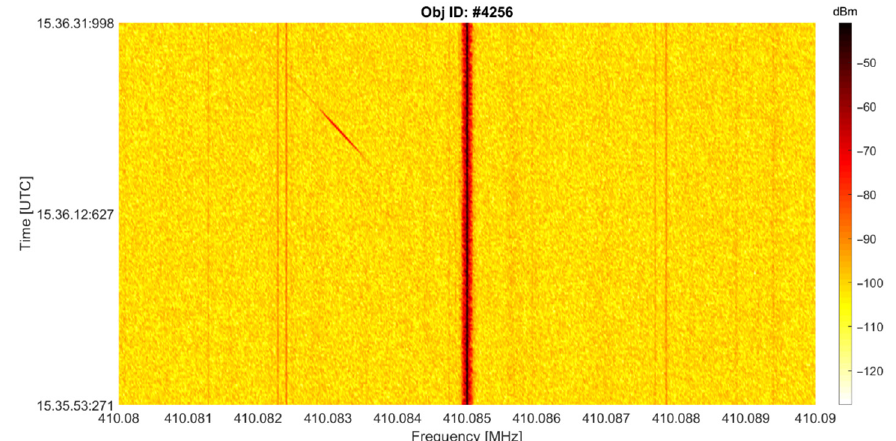
Figure 8. Spectrogram of the passage of the object 4256, registered on 19 May 2019.